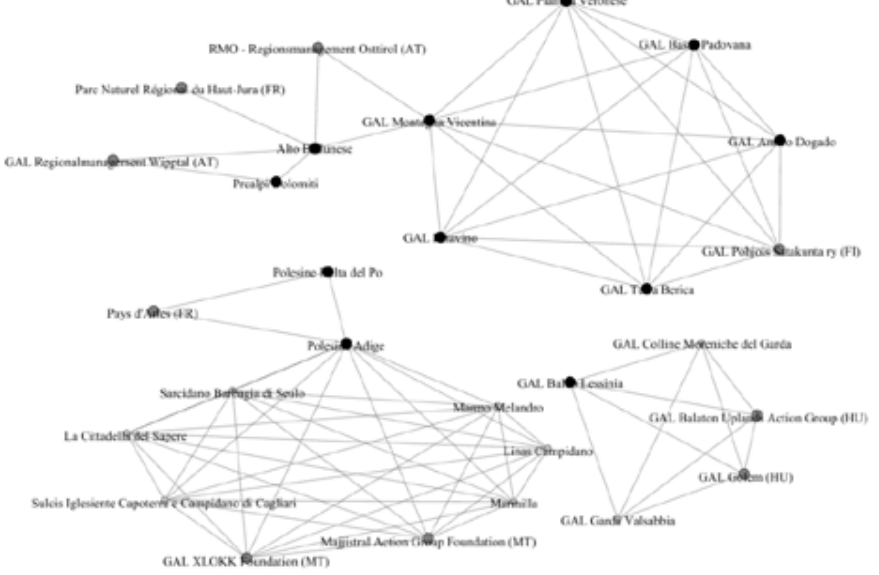
Figure 4. Transnational cooperation network of Veneto LAGs, LEADER